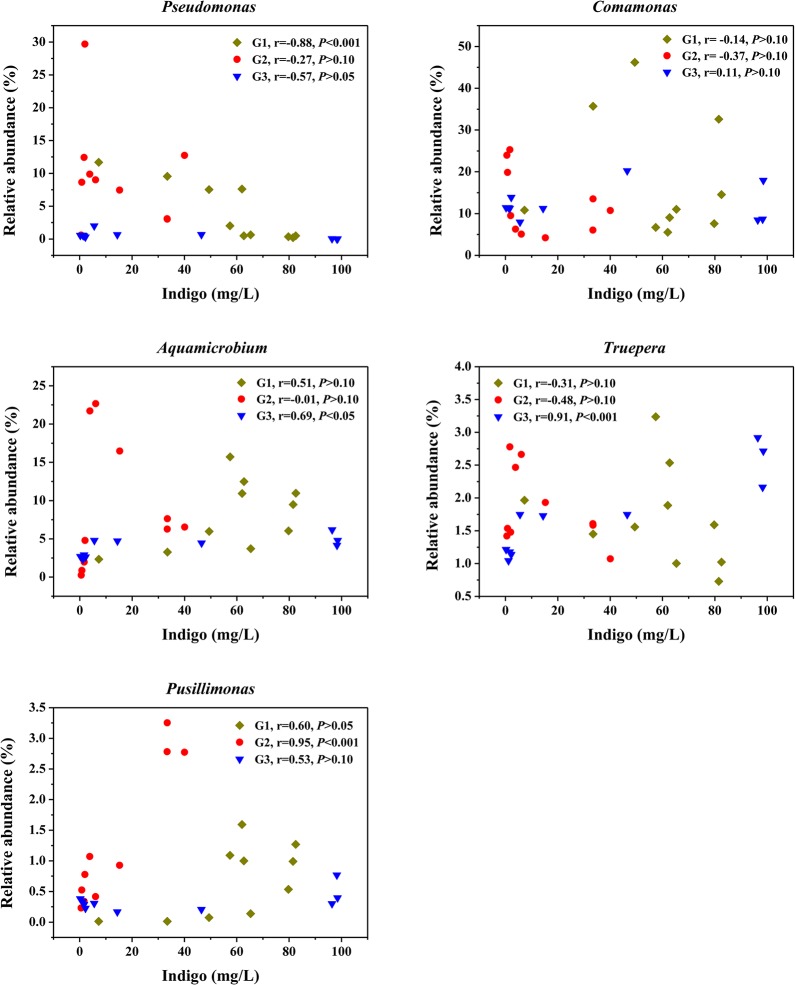
Correlations between the relative abundance of different genera and indigo yields.Pearson correlation coefficients (r) with the associated P values were shown for each genus of each group.